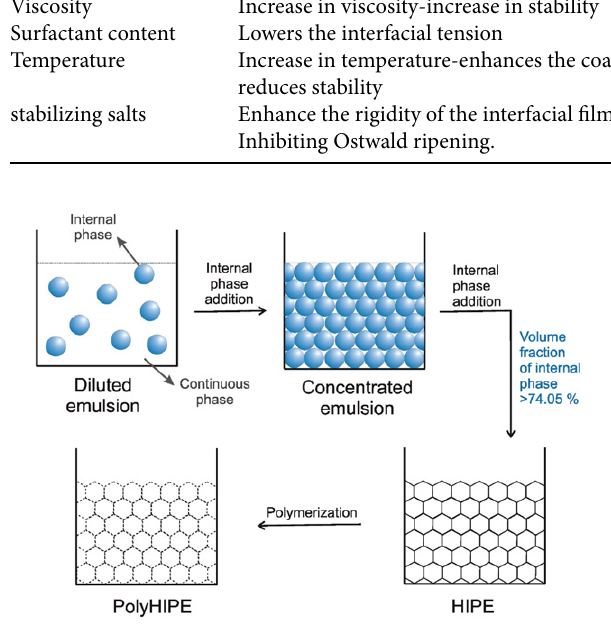
Figure 5 : polyHIPE preparation